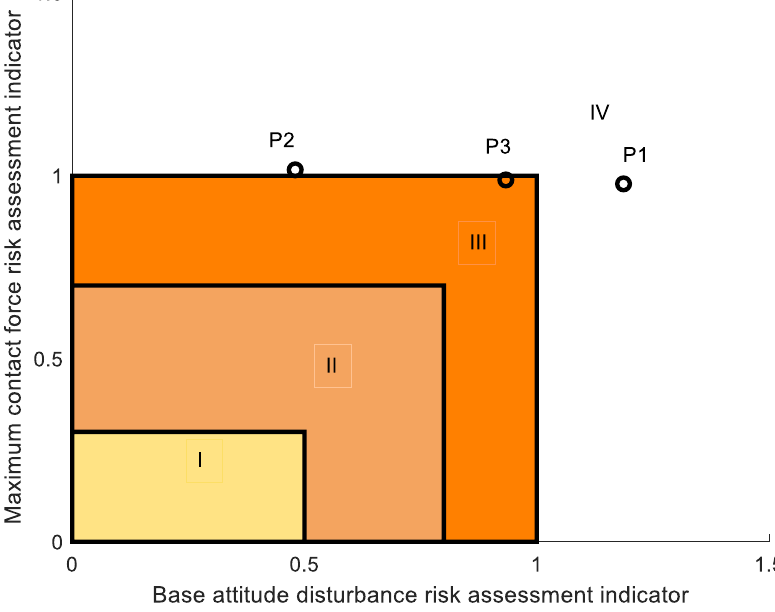
Figure 11. The risk assessment results of contact task.